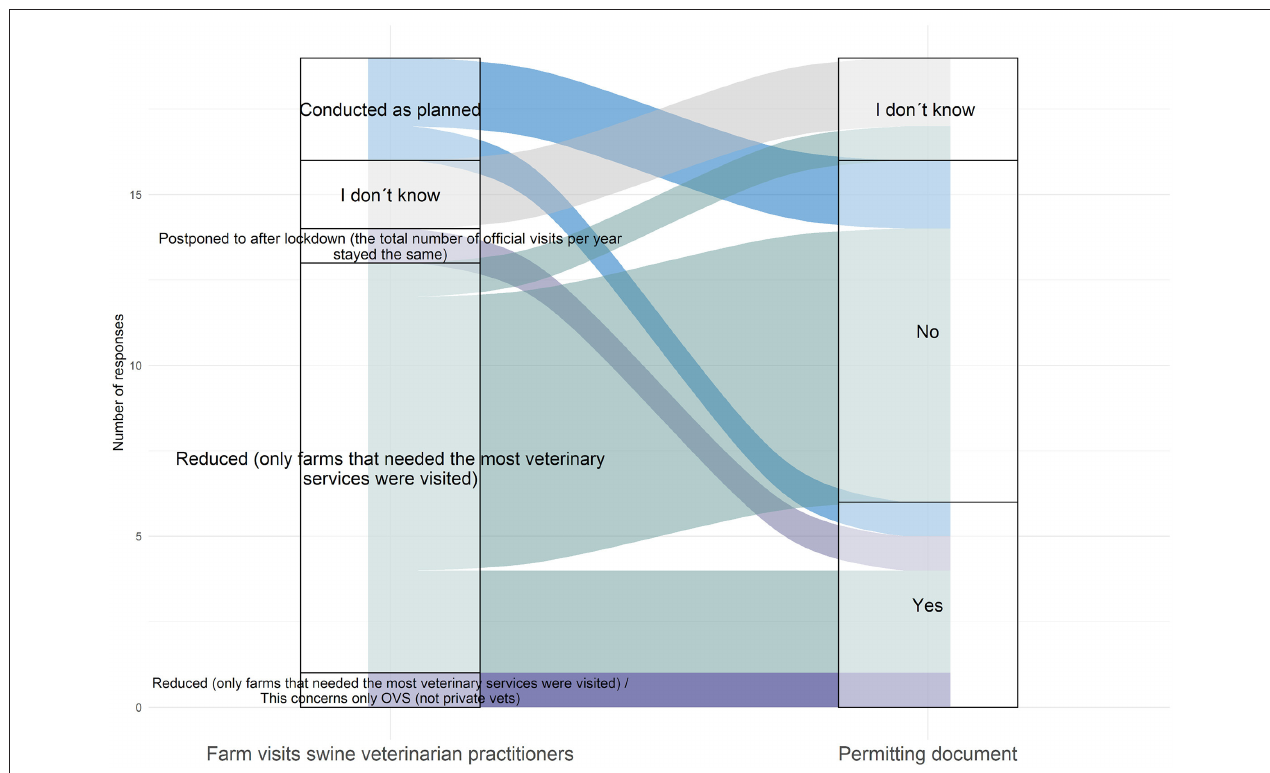
FIGURE 4 | Sankey diagram showing different modalities and adaptations of the swine veterinary practitioner activities, over the period March-May 2020, as reported by 19 survey participants from 18 countries (OVS: Official